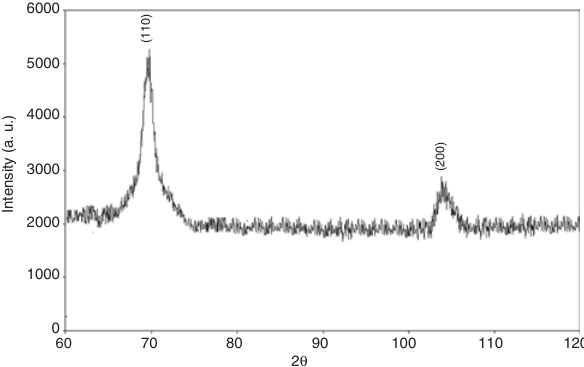
Figure 8: XRD pattern of Fe nanoparticles.